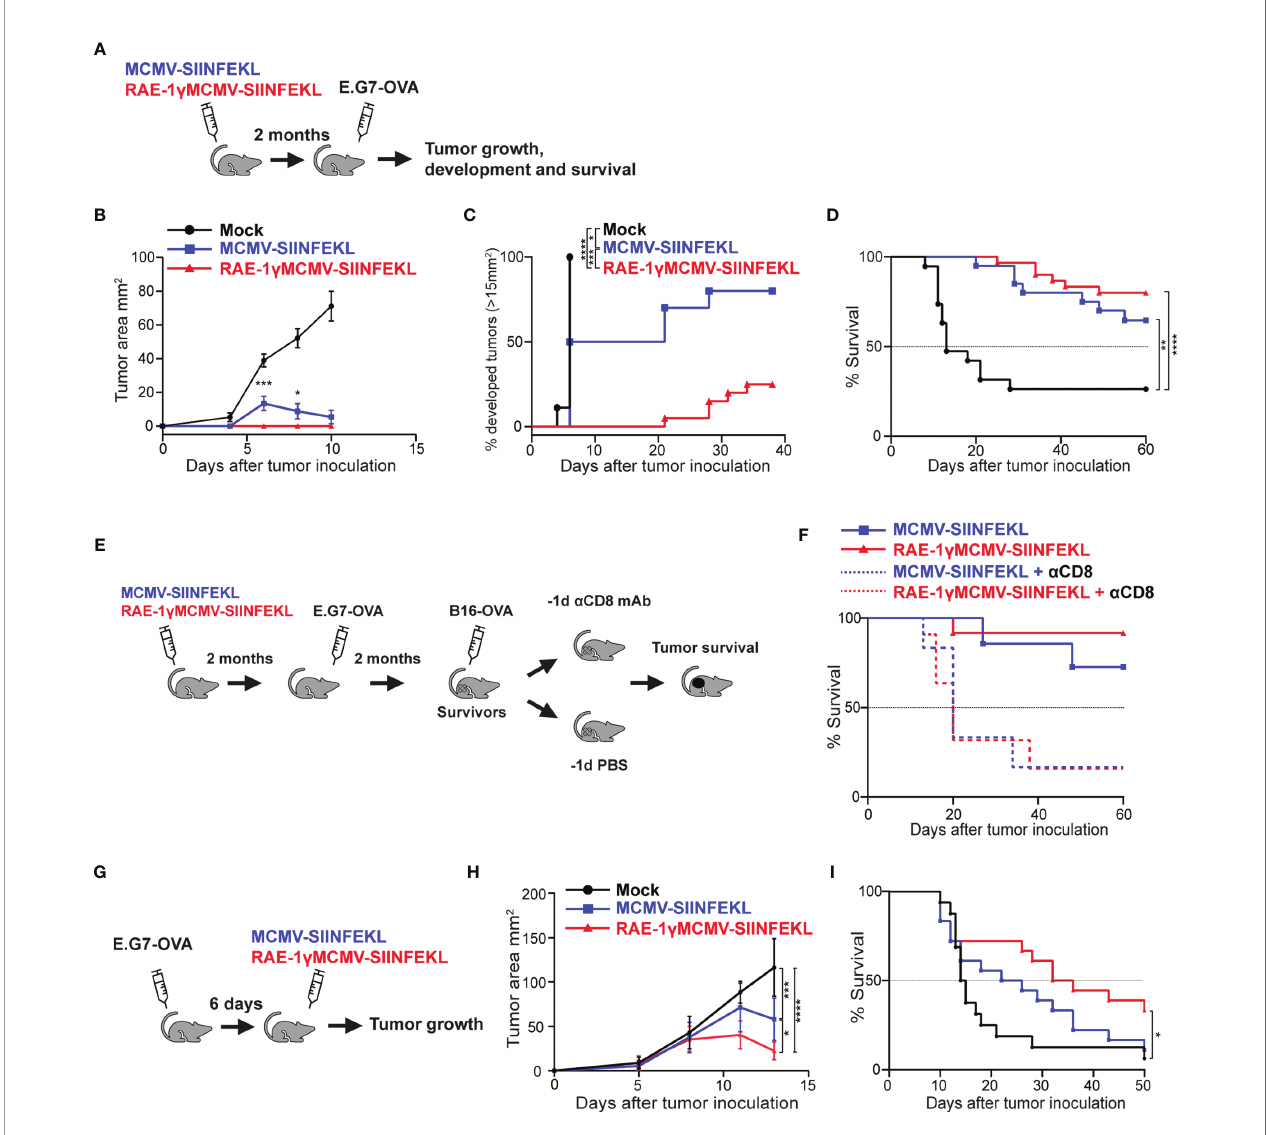
FIGURE 1 | RAE-1 g MCMV-SIINFEKL confers robust long-term protection against subcutaneous tumor challenges. (A) Mice were immunized with either MCMV- SIINFEKL, RAE-1 g MCMV-SIINFEKL, or left unimmunized (n=10-20). 2 months after immunization, mice were inoculated with E.G7-OVA tumor subcutaneously. (B) Tumor growth was followed over time. (C) Percent of mice that developed tumors (>15 mm 2 ). (D) Overall survival after E.G7-OVA challenge. (E) Mice that survived the initial E.G7-OVA challenge were further challenged with B16-OVA subcutaneously. Half of the survivors were depleted for CD8 T cells prior to the secondary challenge. (F) Overall survival of mice after secondary challenge. (G) Mice were inoculated with E.G7-OVA subcutaneously. 6 days later, mice were immunized with indicated vectors or left unimmunized (n=10). (H) Tumor growth and (I) overall survival were followed over time. Prophylactic data are from a single experiment representative of two independent experiments (B, C) . Survival data are pooled from two independent experiments (D, F) . Therapeutic data are from a single experiment representative of two independent experiments (H) , and survival data are pooled from two independent experiments (I) . Data are represented as mean ± SEM (B, H) and statistical signi fi cance is expressed as *p < 0.05, **p < 0.01, ***p < 0,001, ****p<0,0001. Statistical signi fi cance was tested using one-way ANOVA followed by LSD post test (B, H) or log-rank Mantel-Cox test for Kaplan-Maier curves (C, D, F, I)